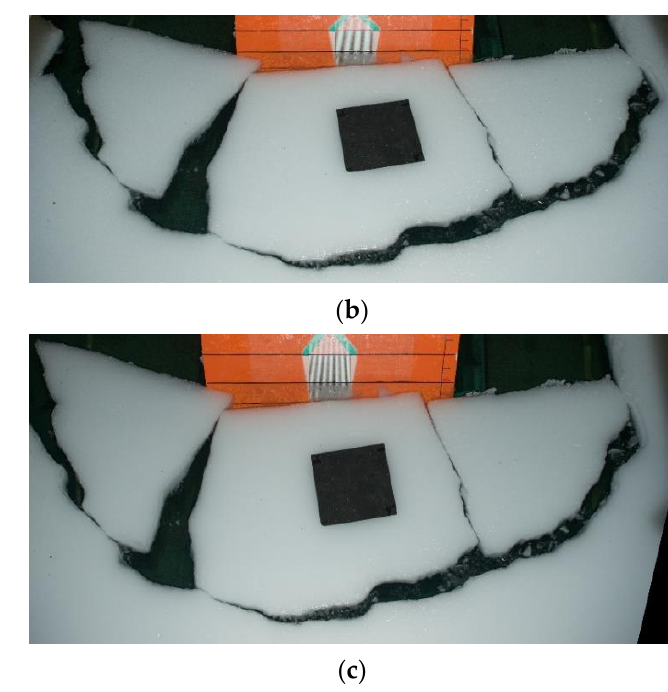
Figure 6. The examples of orthorectification: ( a ) Beam 1, orthorectified from 𝛼 = 18° ; ( b ) Plane 1, the original image, 𝛼 = 35° ; ( c ) Plane 1, the orthorectified image.